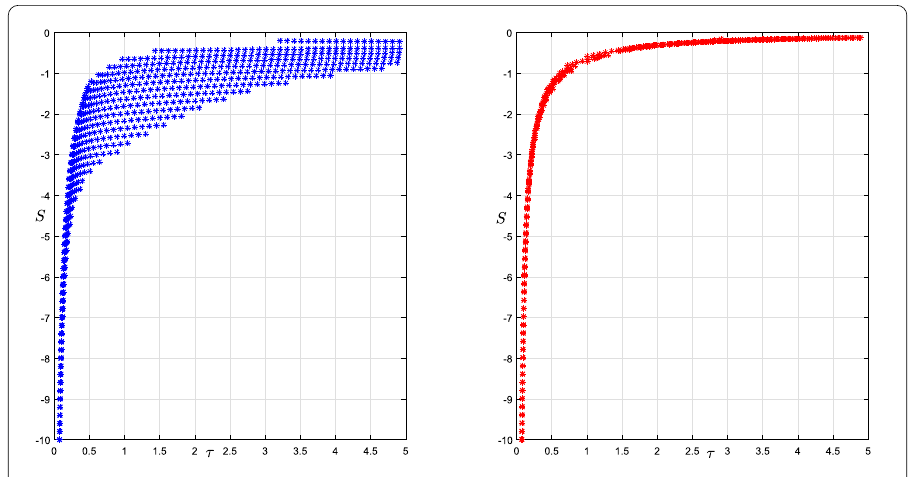
Figure 2 Relations between R e ( s ) and τ when α = 0.2 (left is det( (cid:7) ( s )) = 0, right is Eq.